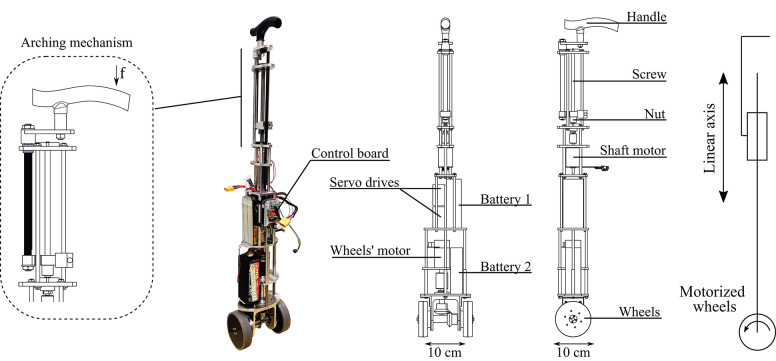
Mechanical structure of the robotic cane. With the arching mechanism (left), a force f on the handle results in a torque, inducing friction between the black and the blue pieces. The black piece is arched and the handle can not move downwards.